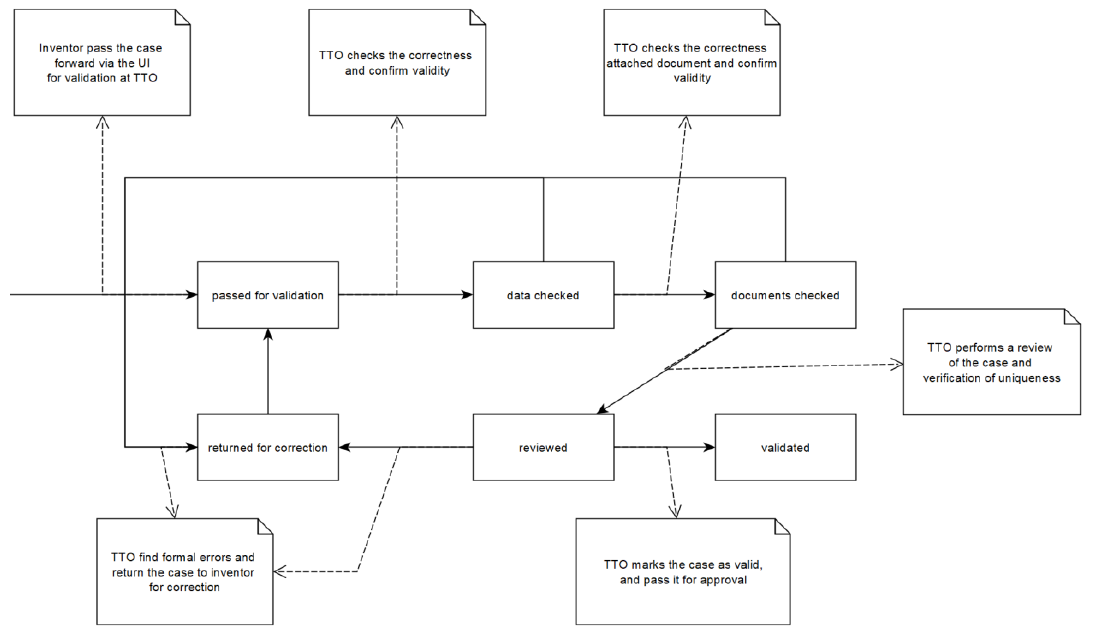
Figure 4. States of process “Process—Validation”, which is important to reach the validated form of the IP case to ensure it is clear from all possible mistakes.